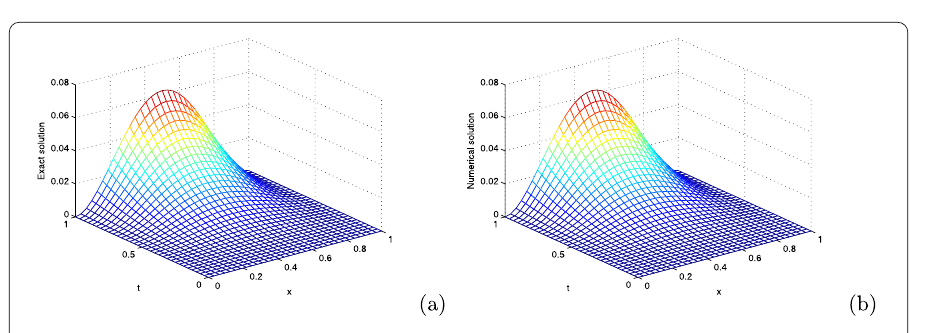
Figure 7 Exact solution ( a ) and numerical solution ( b ) for Example 4 with α = 0.8, h = 1/32, τ =